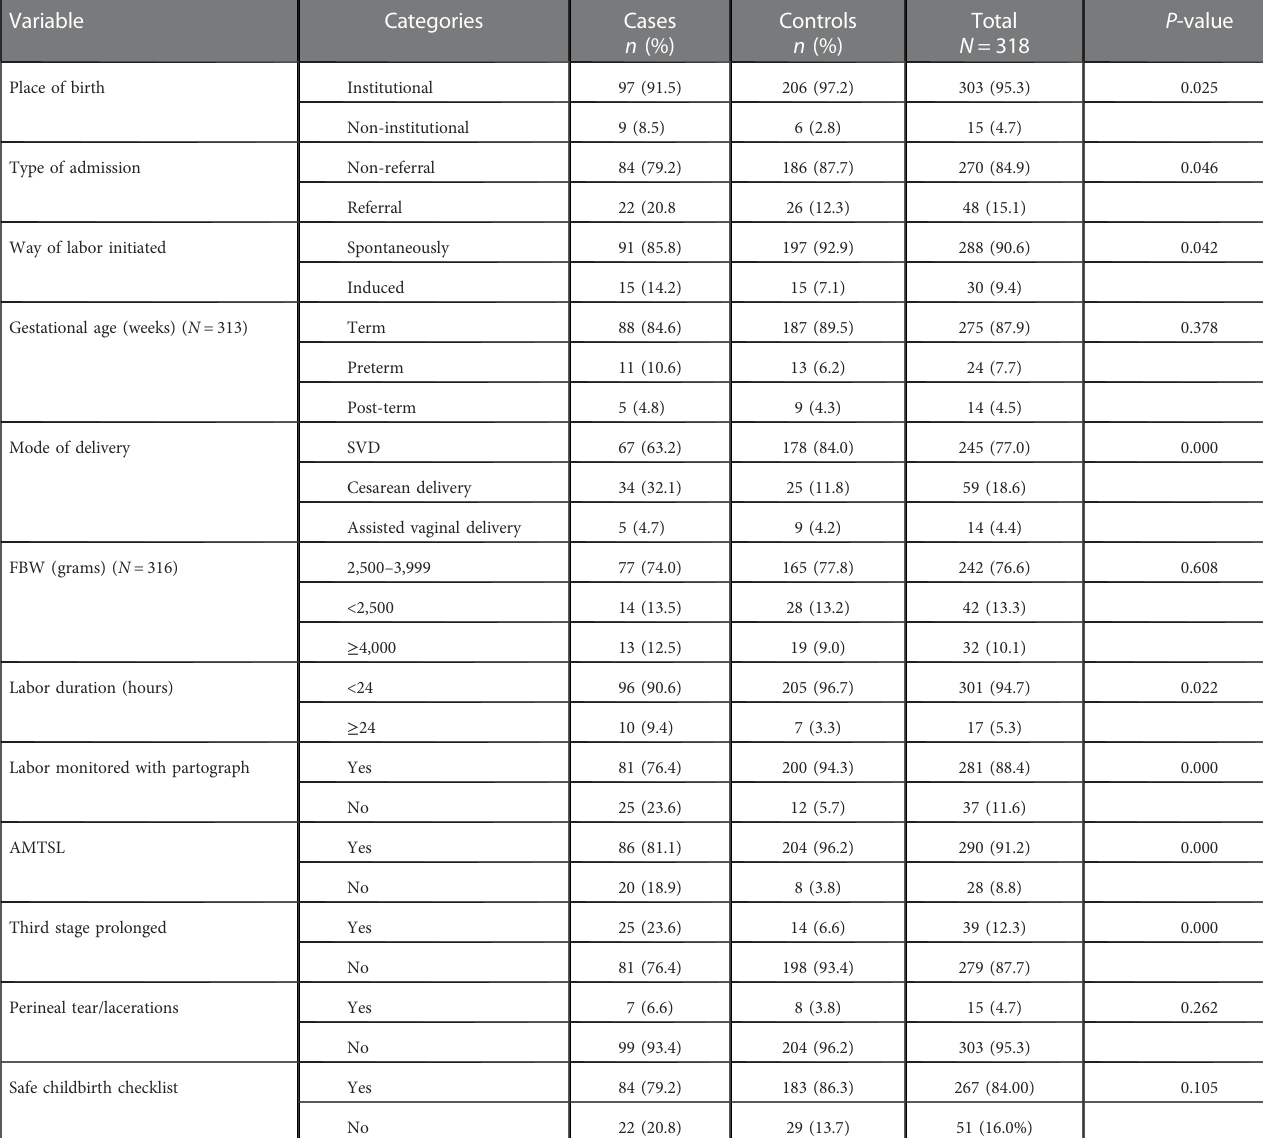
TABLE 4 Intrapartum and postpartum characteristics of study participants with and without primary postpartum hemorrhage in the public hospital of southern Tigray, Ethiopia,